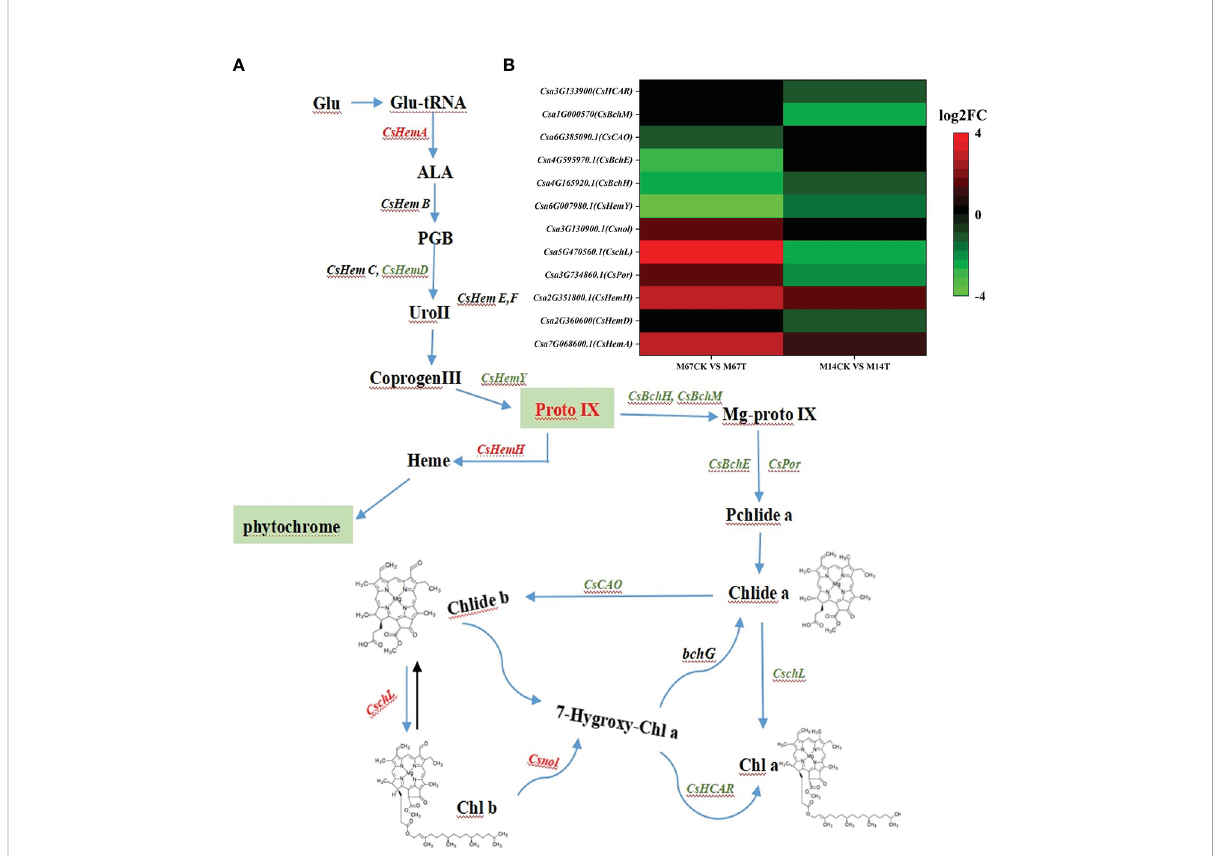
FIGURE 8 (A) Pathway of porphyrin and chlorophyll metabolism, and green letters were downregulated expression genes and red letters represented upregulated expression genes. (B) The Expression patterns of the differently expressed genes (DEGs) induced by low-light stress in the pathway of porphyrin and chlorophyll metabolism pathway. The expression levels were calculated in fragment per kilobase per million reads (FPKM) from triplicate experiments. The heat map shows the normalized value Z-score after log2 (FPKM) transformation. The color in the heat map represents the Z-score after the transformation of log2 (mean FPKM). Each row in the heat map represents the levels of a DEG under different conditions. The DEG name and the gene ID in parenthesis were listed on the right side of the heat